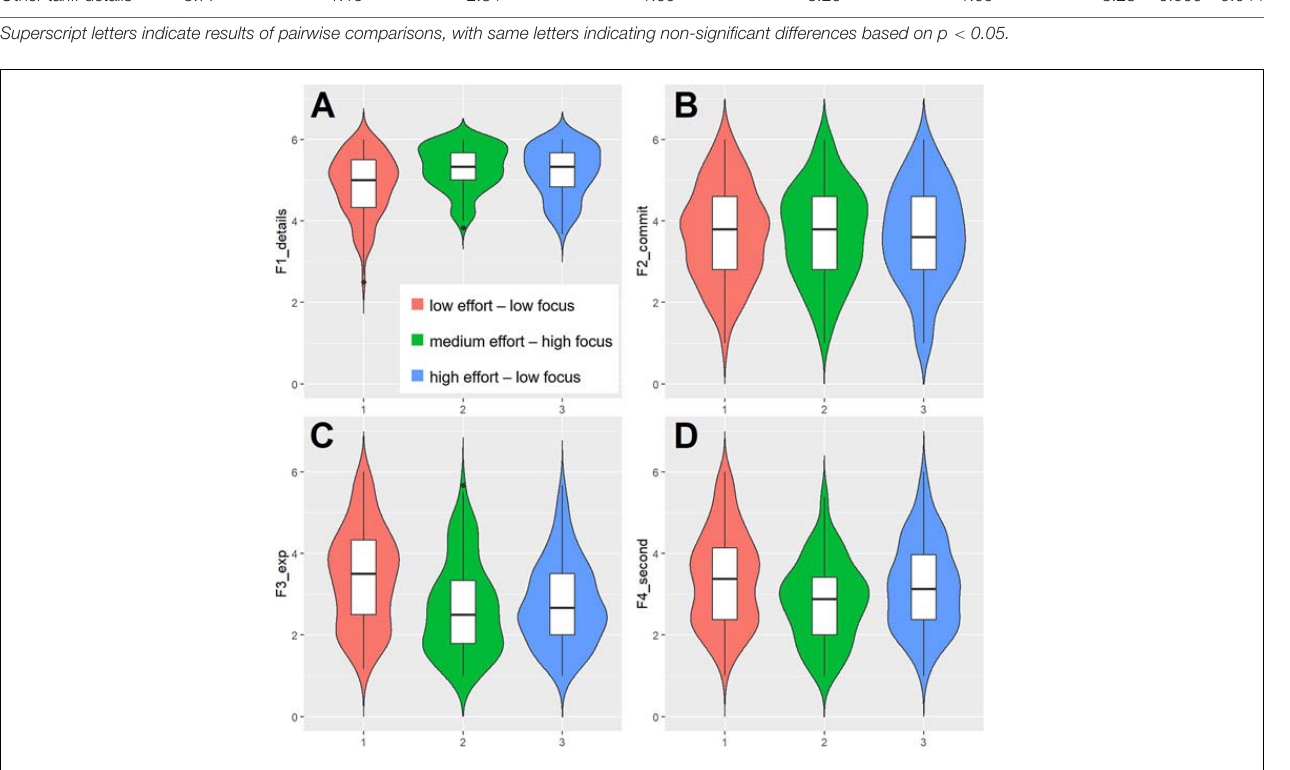
FIGURE 3 | Box and violin plots of the subjective relevance ratings of the four decision factors as a function of cluster assignment regarding (A) substantial contract details; (B) commitment/flexibility; (C) personal experience; and (D) secondary contract details. Note: Boxes depict interquartile range with median in the center; density curves depict the distribution of the